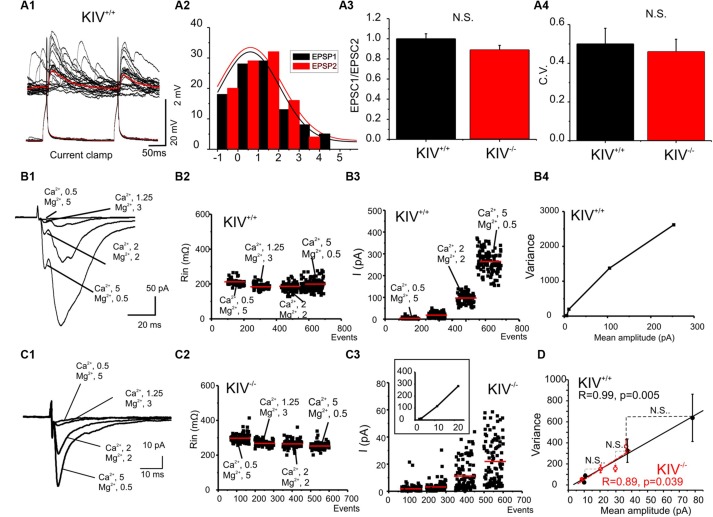
Unaltered presynaptic glutamatergic transmission in KIV-/- mice. (A) Paired recordings from a pair of synaptic connected cells in layer IV in a wild-type mouse. Repetitive action potentials (bottom) in a spiny stellate cell induced uEPSPs (top) in a post-synaptic spiny stellate cell (A1). The averaged uEPSPs (top red trace) showed little short-term depression (A2). (A3,A4) There were no significant differences between the paired-pulse ratios (A3) and CV (A4) of eIPSCs in spiny stellate cells of wild-type vs. mutant (KIV-/-) mice, n = 9 cells in each group. (B,C) EPSCs were evoked in the presence of different extracellular Ca2+/Mg2+ ratios (B1,C1) in wild-type (B) and KIV-/- mice (C). The input resistance (B2,C2), and amplitude of each eIPSC event was plotted against experimental time. (B4) V–M analysis of the same experiments of B1. (D) The V–M analysis of all wild-type mice (black squares, n = 9) and KIV-/- mice (red open circles, N = 9). The linear fitting curves were essentially overlap between wild-type and KIV-/- mice. Statistical analysis were performed between amplitude of eIPSCs evoked in the same conditions. There were no significant differences between the wild-type and KIV-/- mice.